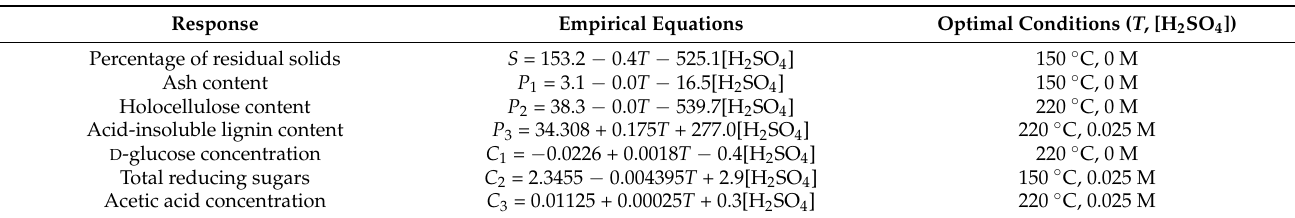
Table 4. Empirical equations for each response and adequate optimal conditions for the thermochemical pretreatment of young cellulosic fibers ( ◦ C, M).